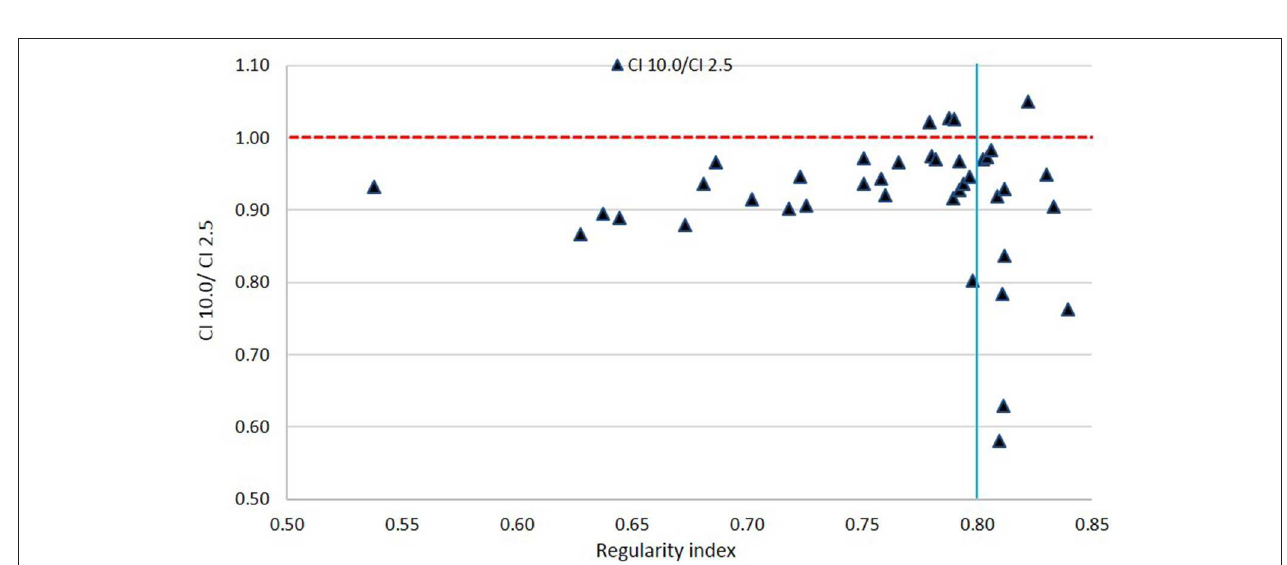
FIGURE 9 | Ratio of Conformity Indices CI 10.0 to CI 2.5 as a function of Regularity Index. The vertical line marks the 0.80 RI value.